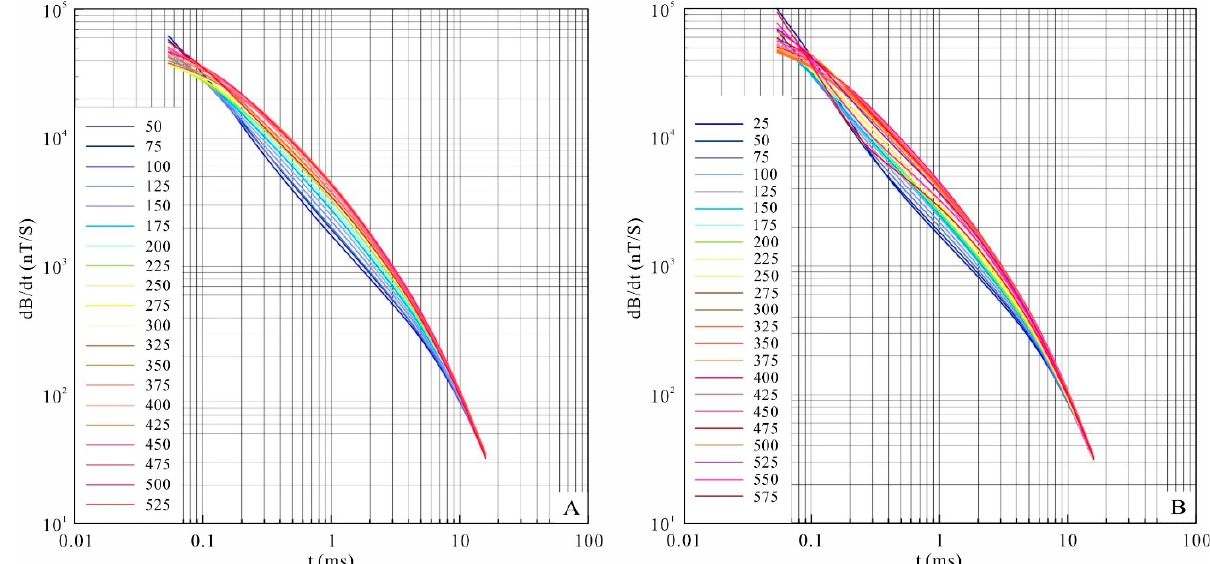
Figure 10. Comparison of the original attenuation curves of the induced electromotive force: ( A ) survey line II-II ′ ; and ( B ) survey line IV-IV ′ ).